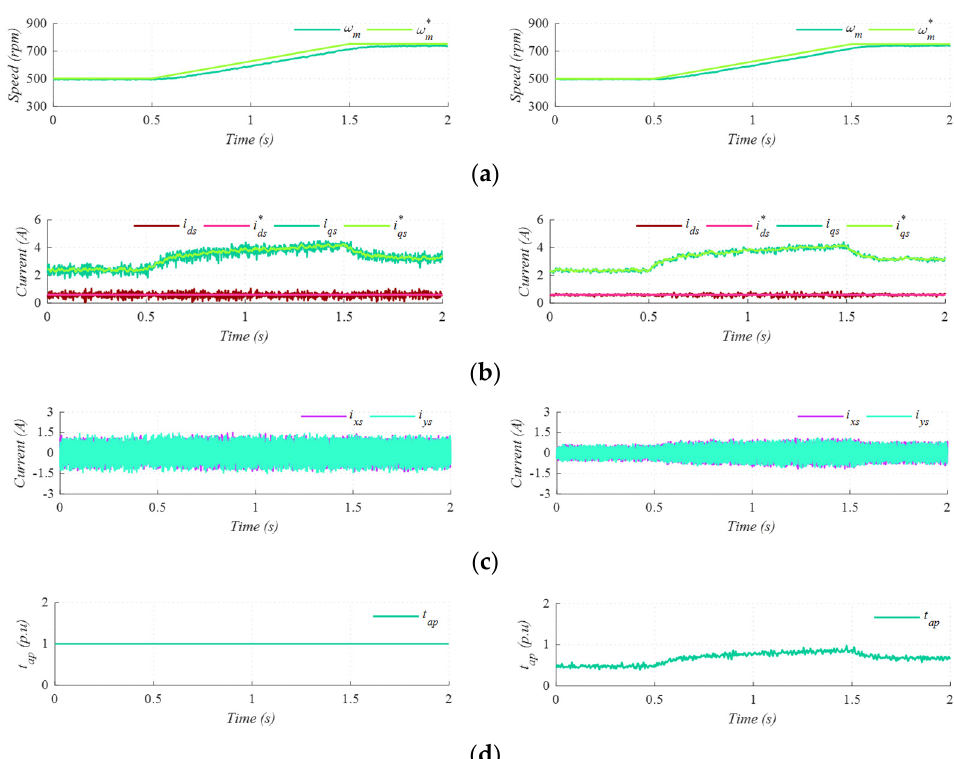
Figure 9. Test 3. Dynamic performance of LVV-MPC (left plots) and PULLA-MPC (right plots). From top to bottom: ( a ) motor speed, ( b ) 𝑑 - 𝑞 currents, ( c ) 𝑥 - 𝑦 currents and ( d ) application time of top to bottom: ( a ) motor speed, ( b ) d - q currents, ( c ) x - y currents and ( d ) application time of active active voltage vectors. voltage